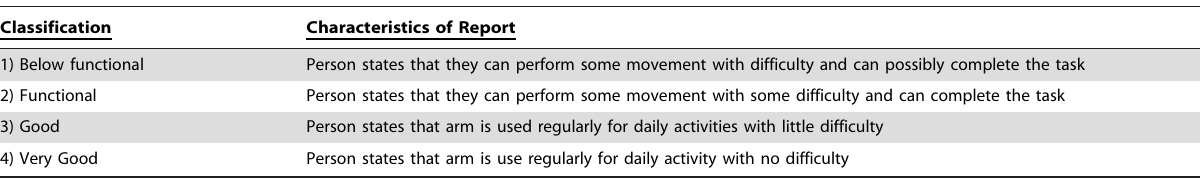
Table 1. Subjective Report of Arm